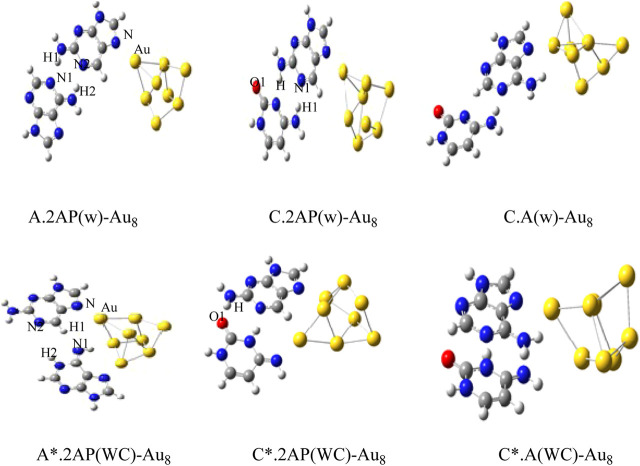
Optimized structures of Au8-wobble/WC mispair Complexes by DFT method. (Srivastava, 2018a).